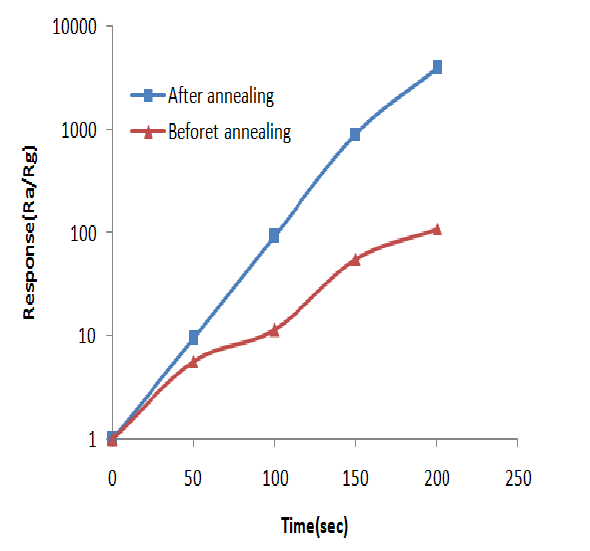
Fig.8: The response of the ZnO gas sensors((annealed and as received ) as a function of H gas concentration at operation 2